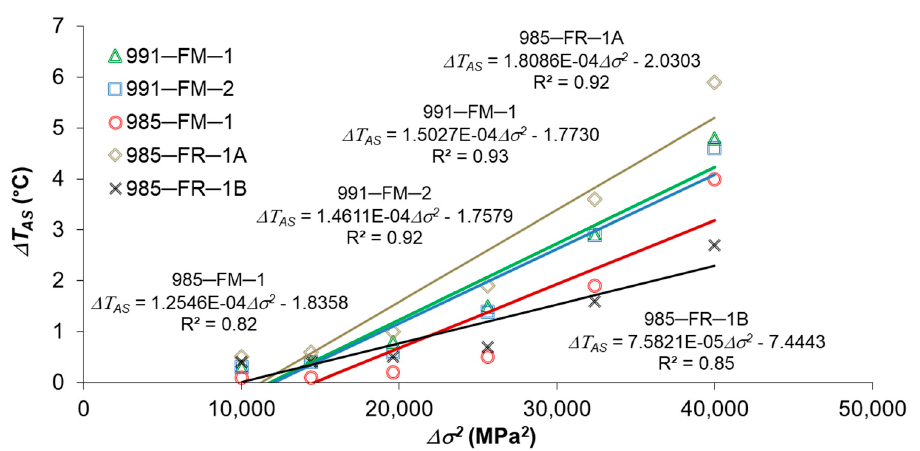
Figure 10. Δ T AS ─ Δ σ 2 curves for type-NC-4 joints.